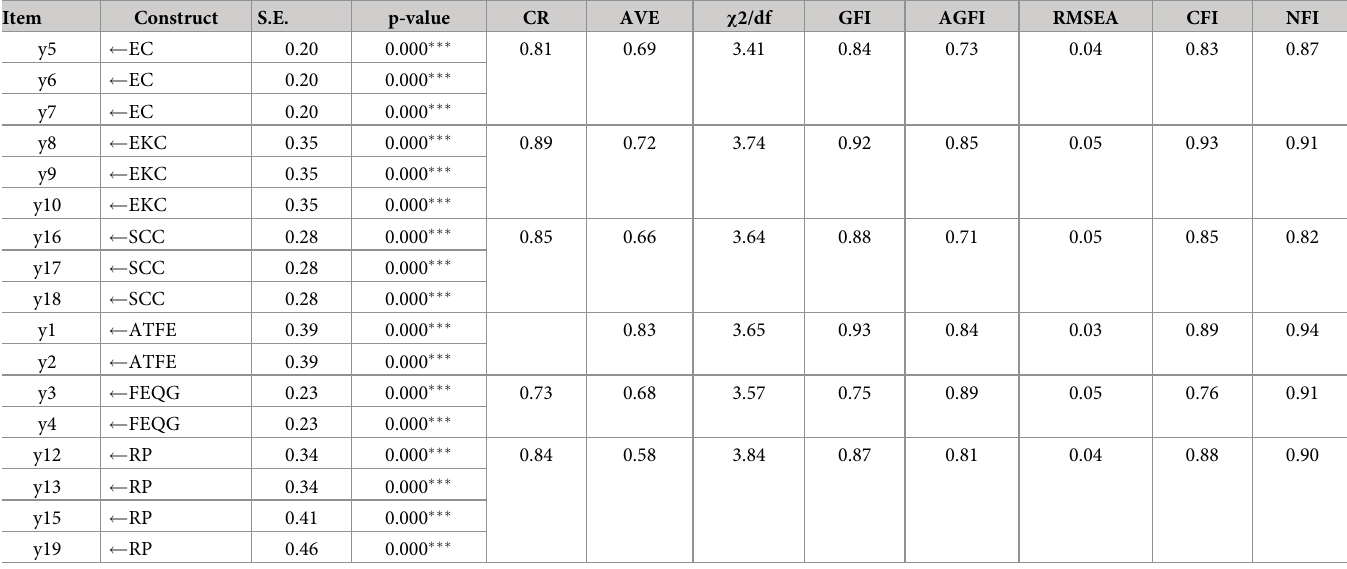
Table 3. Measurement model.